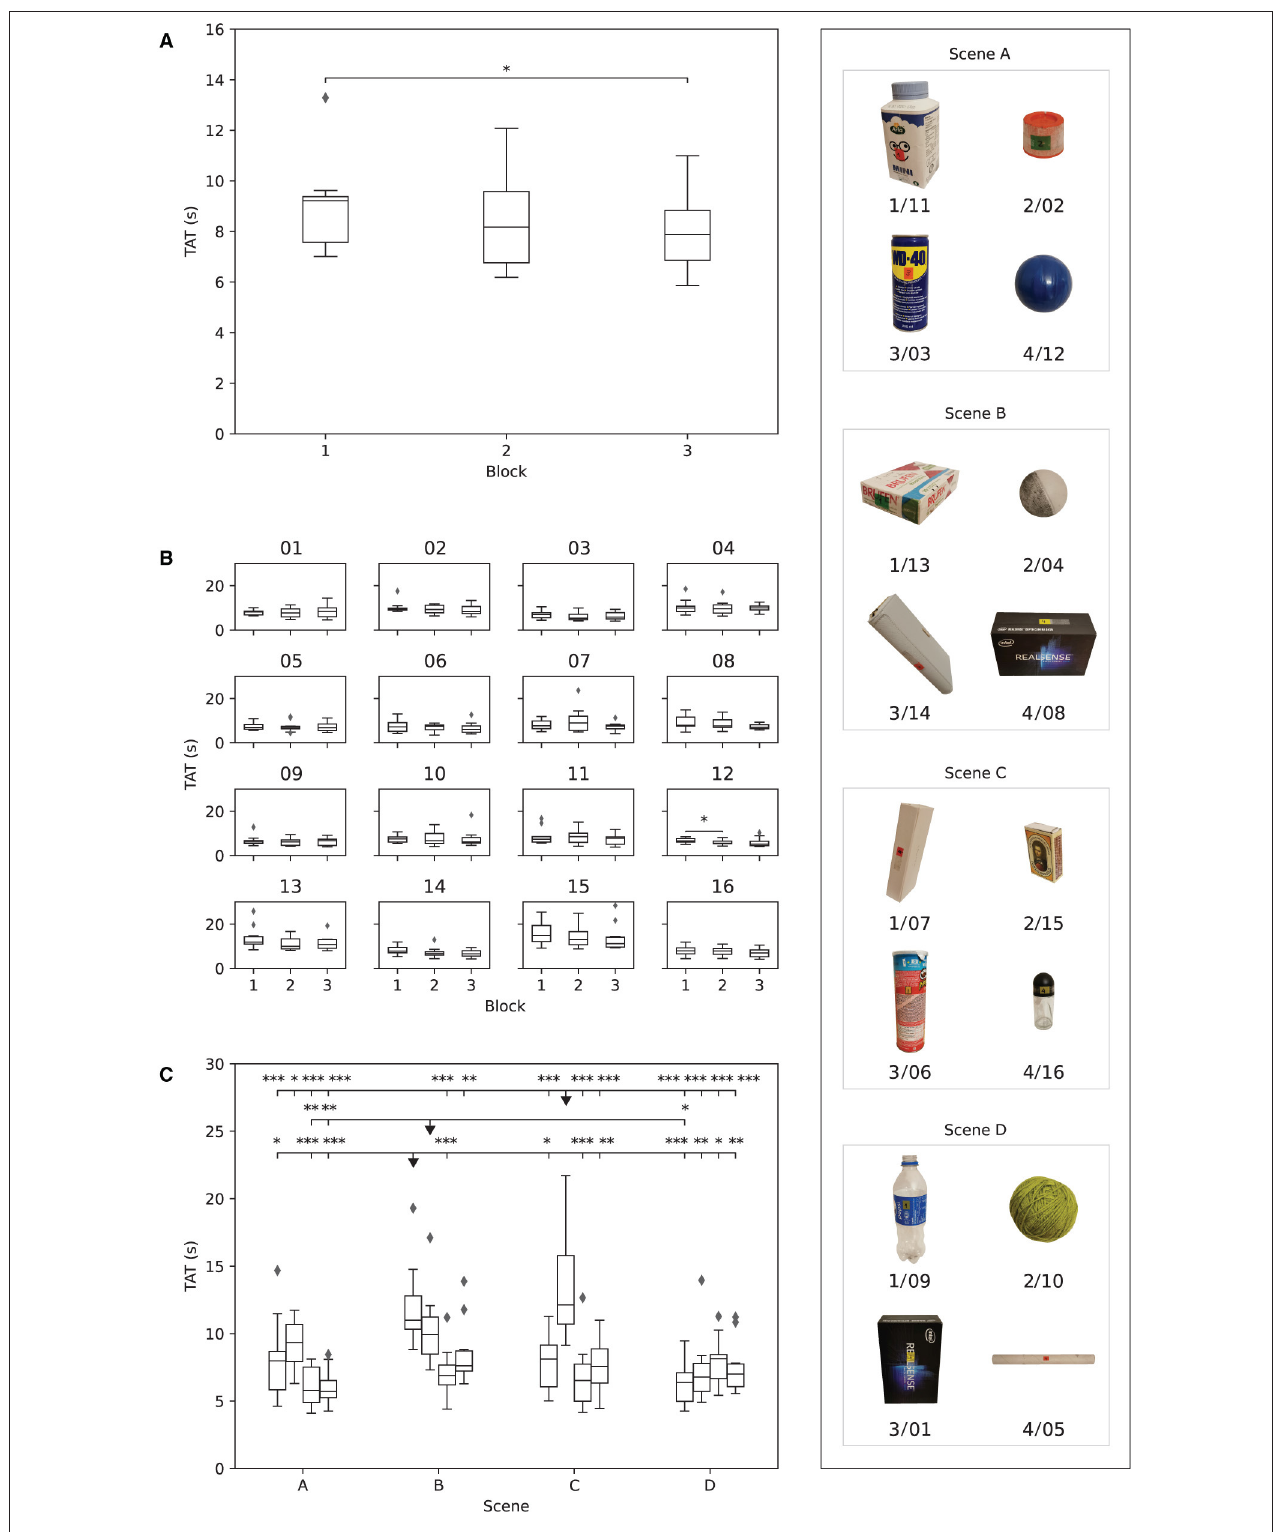
FIGURE 9 | The results obtained in Phase II. The boxplots show: (A) median time to accomplish the task (TAT) for each subject in each block, (B) median TAT of all subjects for each object in each block, and (C) median TAT per object across all blocks. The boxplots (objects) in each scene are ordered as in Table 1 . The stars indicate statistical significance (* p < 0.5; ** p < 0.01; *** p < 0.001).